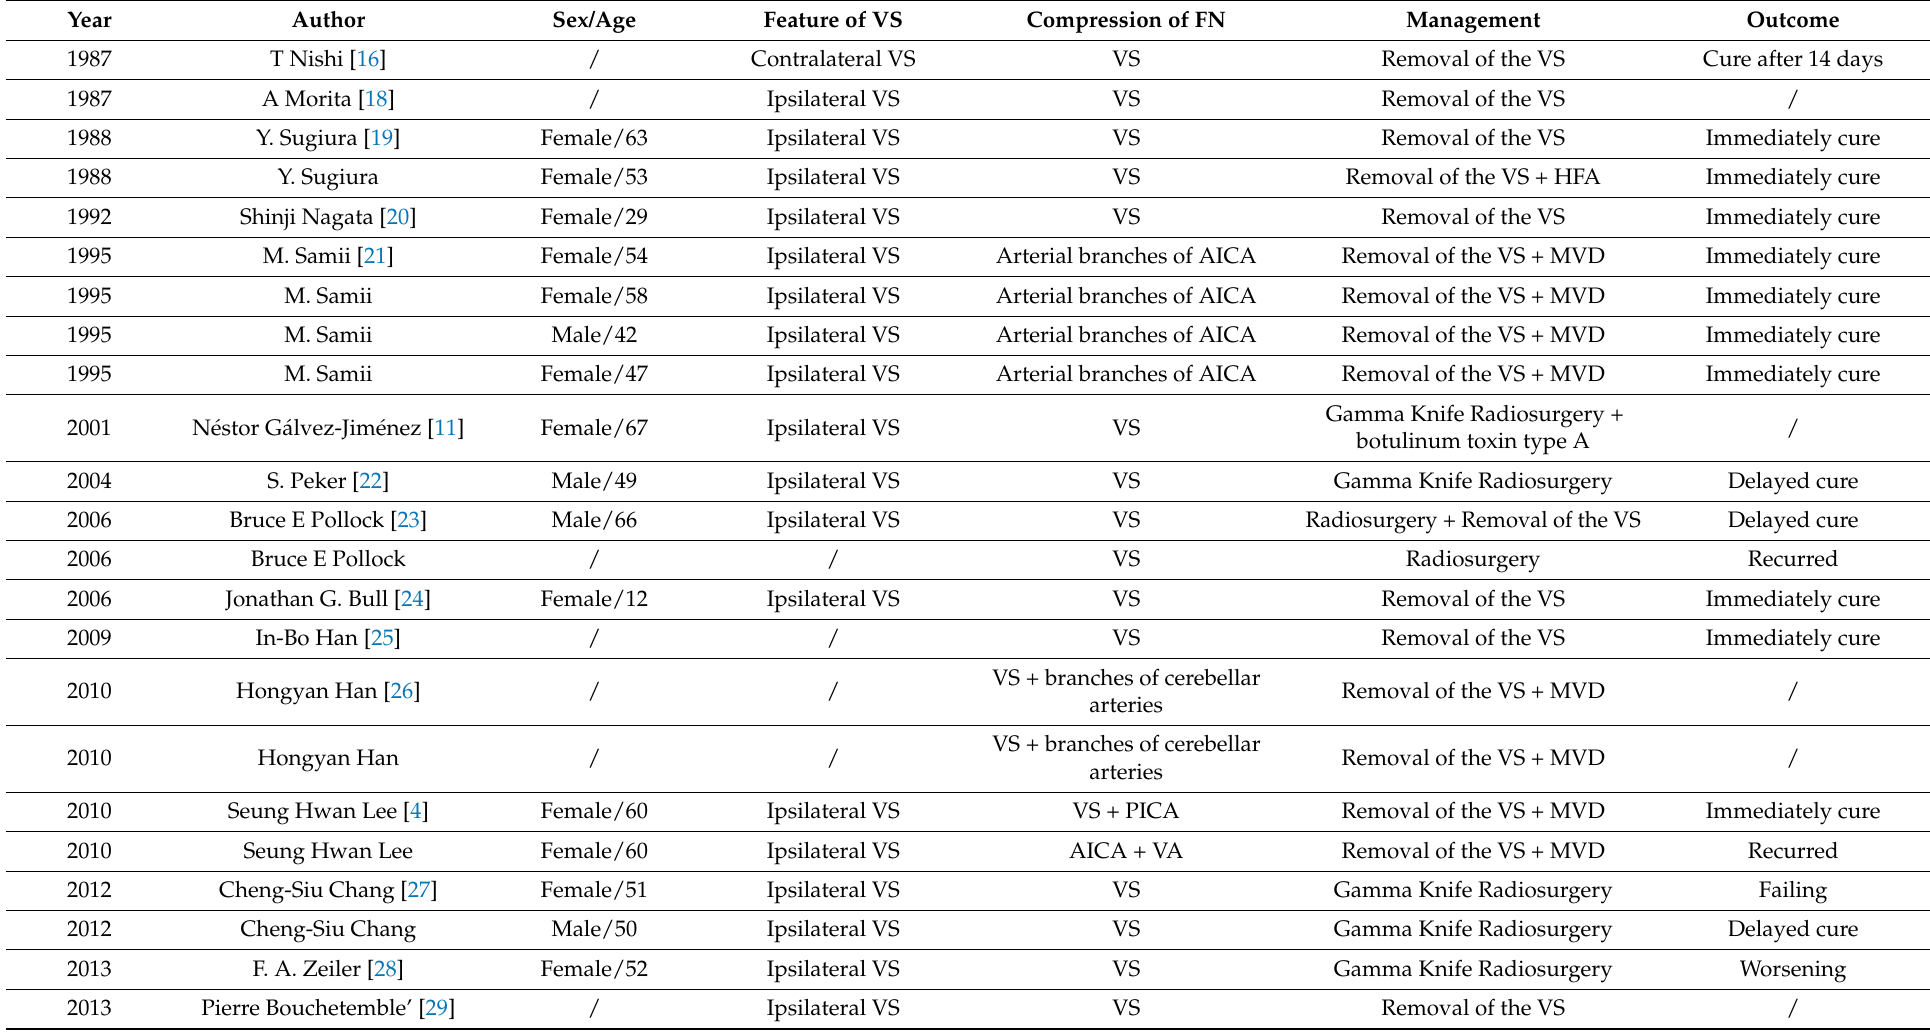
Table 1. Summary of reports of hemifacial spasm caused by or coexisted with vestibular